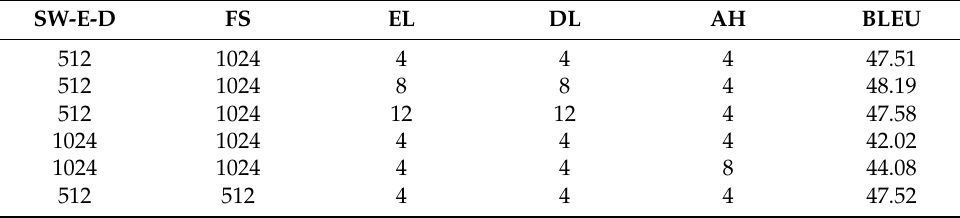
Table 3. Results of the Transformer-Based NMT Subword Model on MADAR–Nile Basin corpus for NILE–MSA translation task, where SW-E-D is the Subword embedding dimension, FS is the filter size, EL is the encoder layer, DL is the decoder layer and AH is the attention heads number. SW-E-D